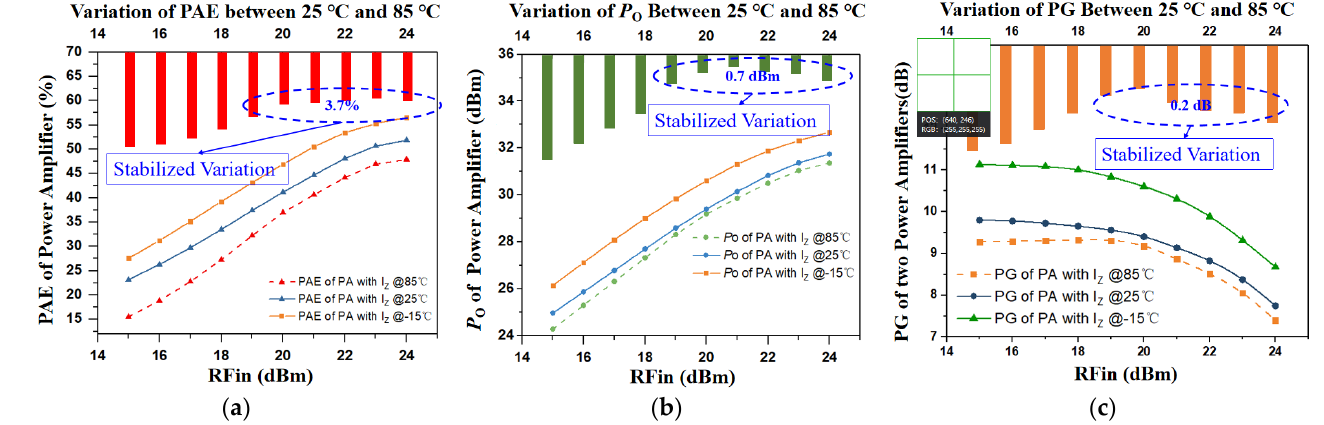
Figure 9. ( a ) Measured PAE of proposed bias PA; ( b ) Measured P o of proposed bias PA; ( c ) Measured PG of the proposed bias PA over input power at − 15 °C, 25 °C and 85 °C. The measured ACPR and EVM at different temperatures are summarized in Table 2.